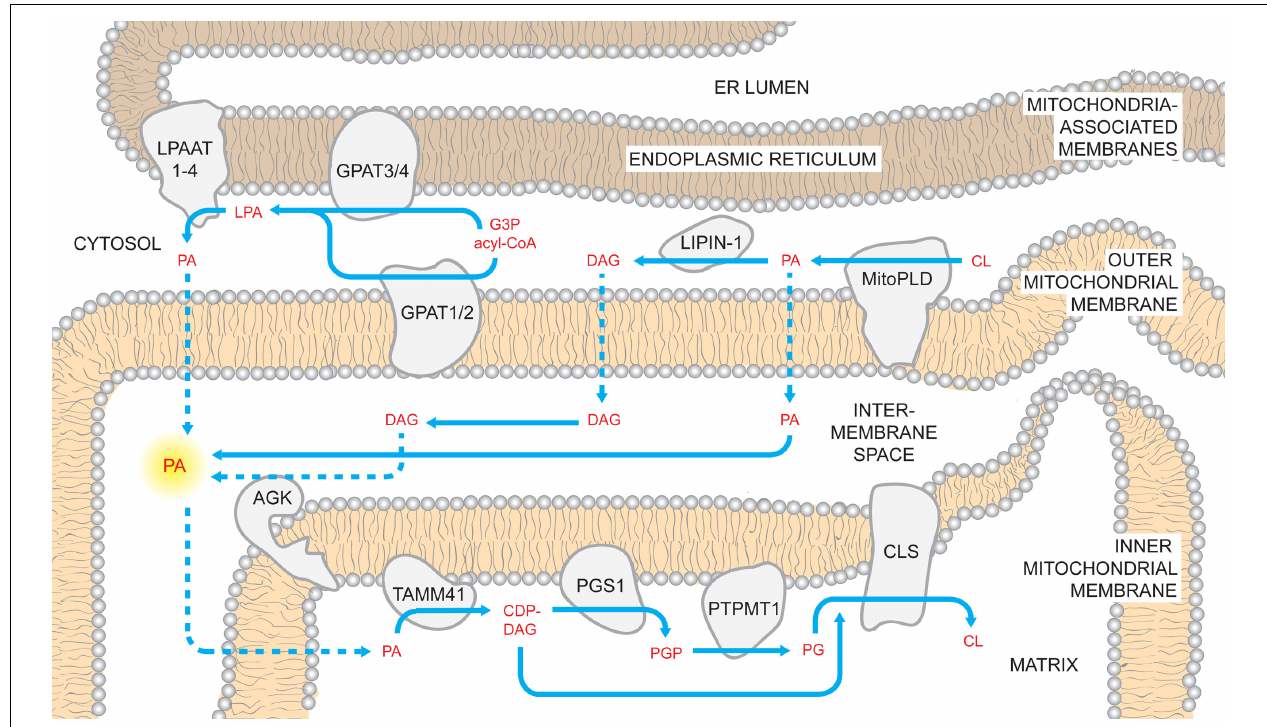
FIGURE 1 | Mammalian cardiolipin biosynthesis. CL biosynthesis likely involves PA sourced from multiple pathways. PA can be generated by LPAATs which acylate LPA; LPA can be made using glycerol 3-phosphate (G3P) and acyl-CoAs by mitochondrial and ER GPATs. Additionally, PA can be made on the OMM through the hydrolysis of CL by MitoPLD. In the OMM, PA recruits the phosphatase lipin-1 which dephosphorylates PA into DAG. In turn, DAG may traffic across the OMM and be phosphorylated by AGK forming PA in the